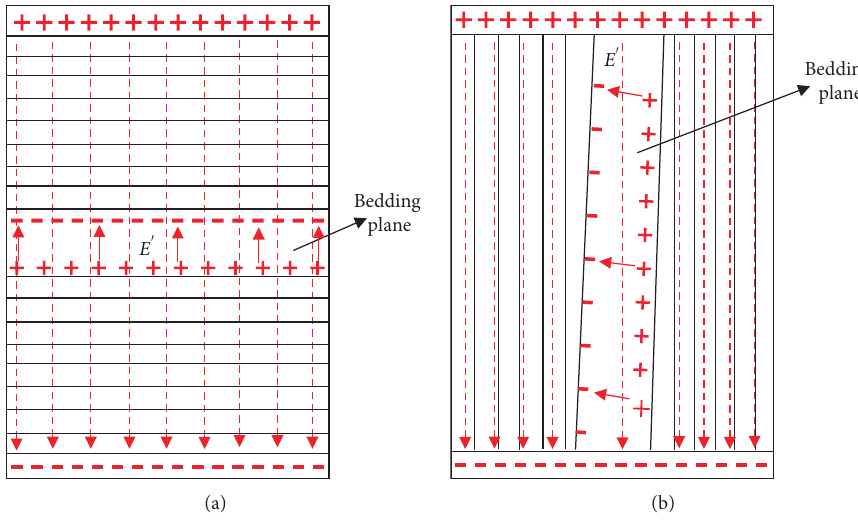
Figure 7: Schematic diagram current conduction. (a) Vertical bedding. (b) Parallel